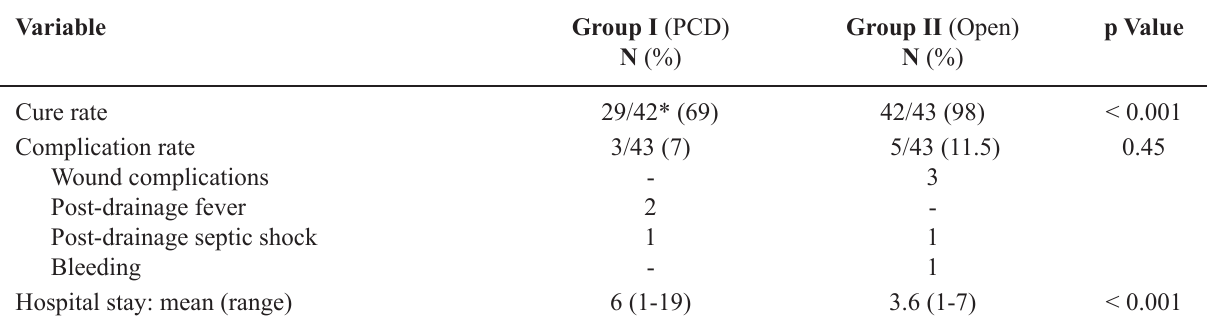
* One patient died and was excluded; PCD = percutaneous drainage; N = number of